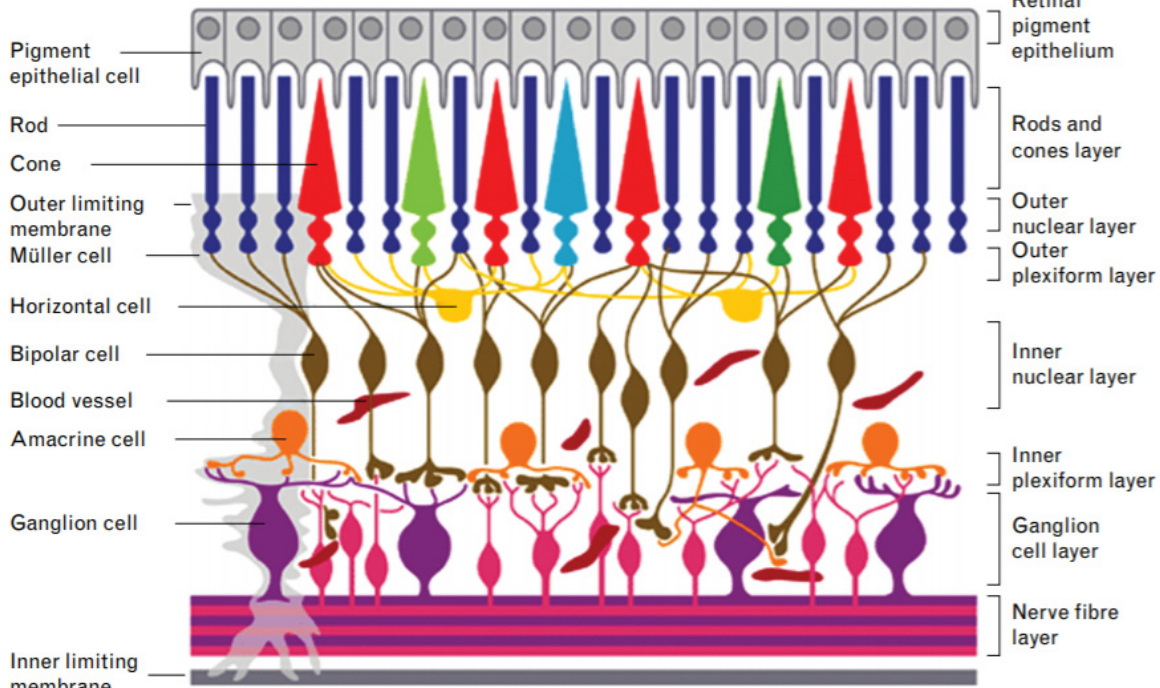
Figure 6. Diagram of the structure of the retina. The different cell types are located in different layers. The light reaches the nerve fiber layer. Ganglion cells transmit signals to bipolar and horizontal cells. Finally, they reach the rods and cones that transform it into electrical signals. The retinal pigment epithelium, formed by the epithelial pigment cells, served as physical, nutritional and signal support to the rest of the retina. Reproduced with permission from [53], Lippincott Williams and Wilkins Ltd., 2016.